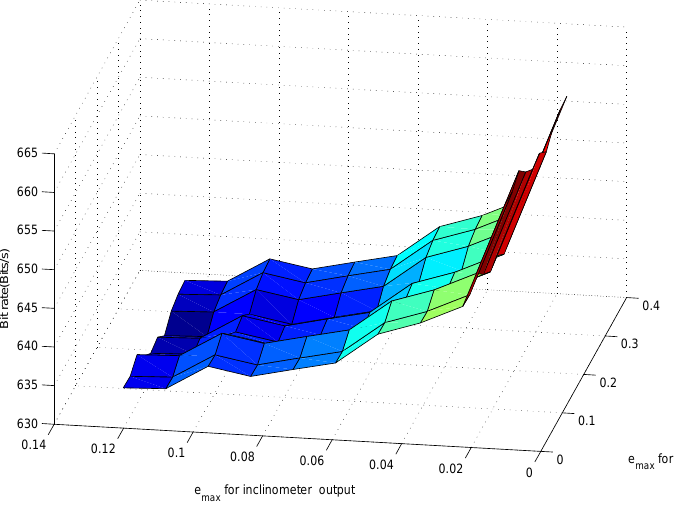
and the bit max